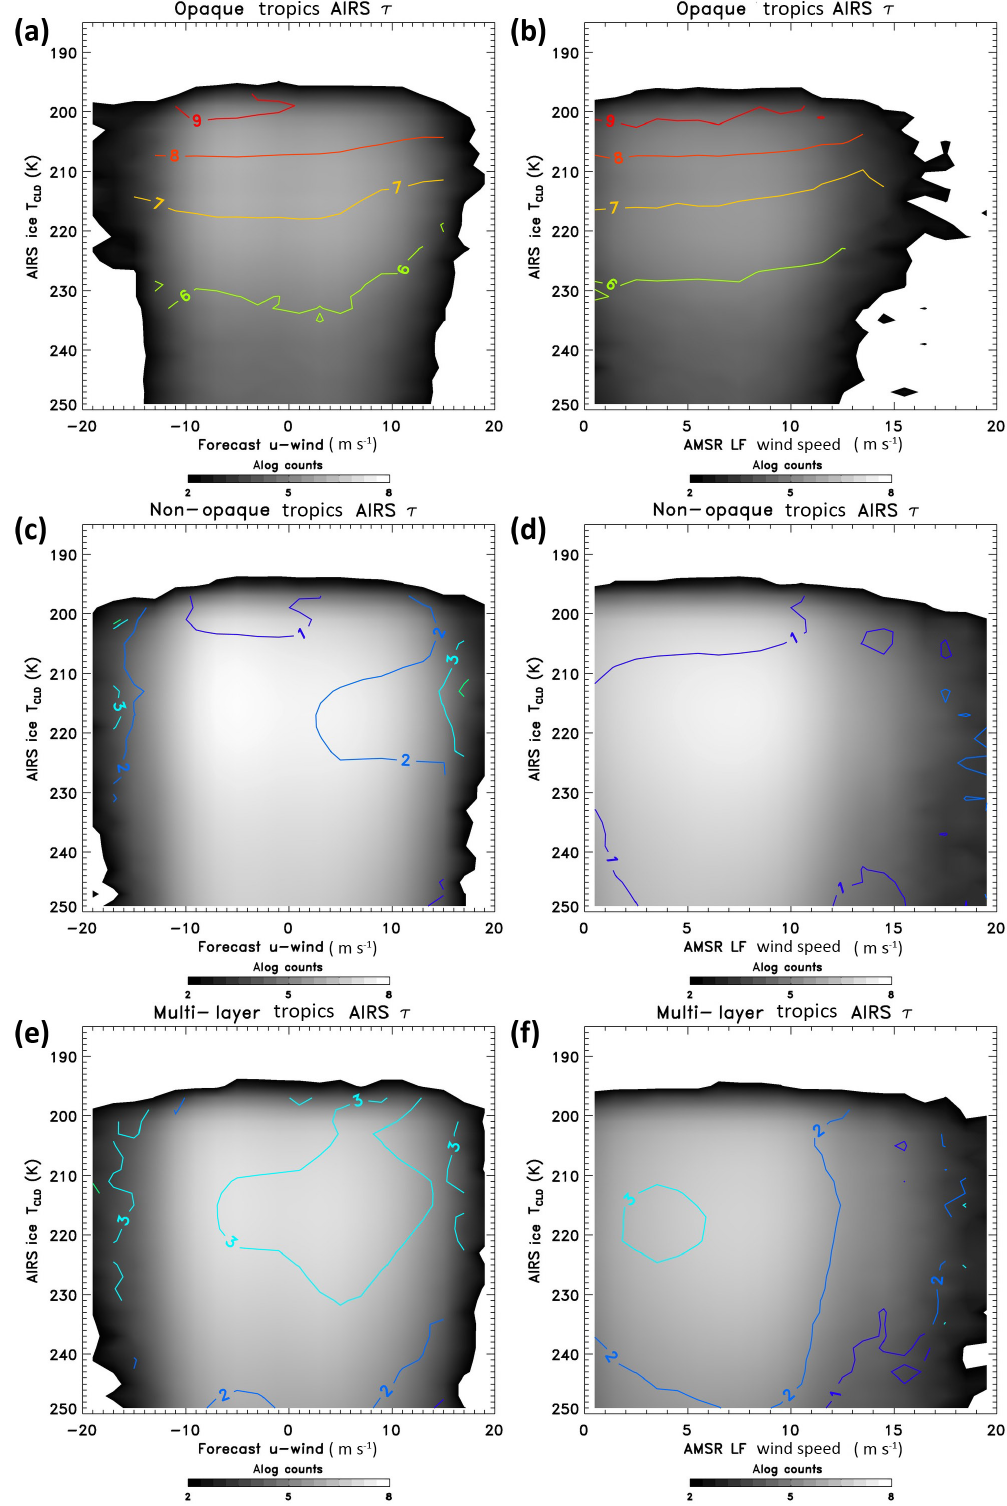
Figure 9. AMSR-E/AMSR-2 low frequency (LF) wind speeds (ms − 1 ) (b, d, f) or NWP model u -component wind speeds (a, c, e) vs. T cld histograms. The log counts are shown as greyscale, the AIRS IR only τ i overlaid as colored contours, with opaque (a, b) , non-opaque (c, d) , and multi-layered (e, f) clouds shown